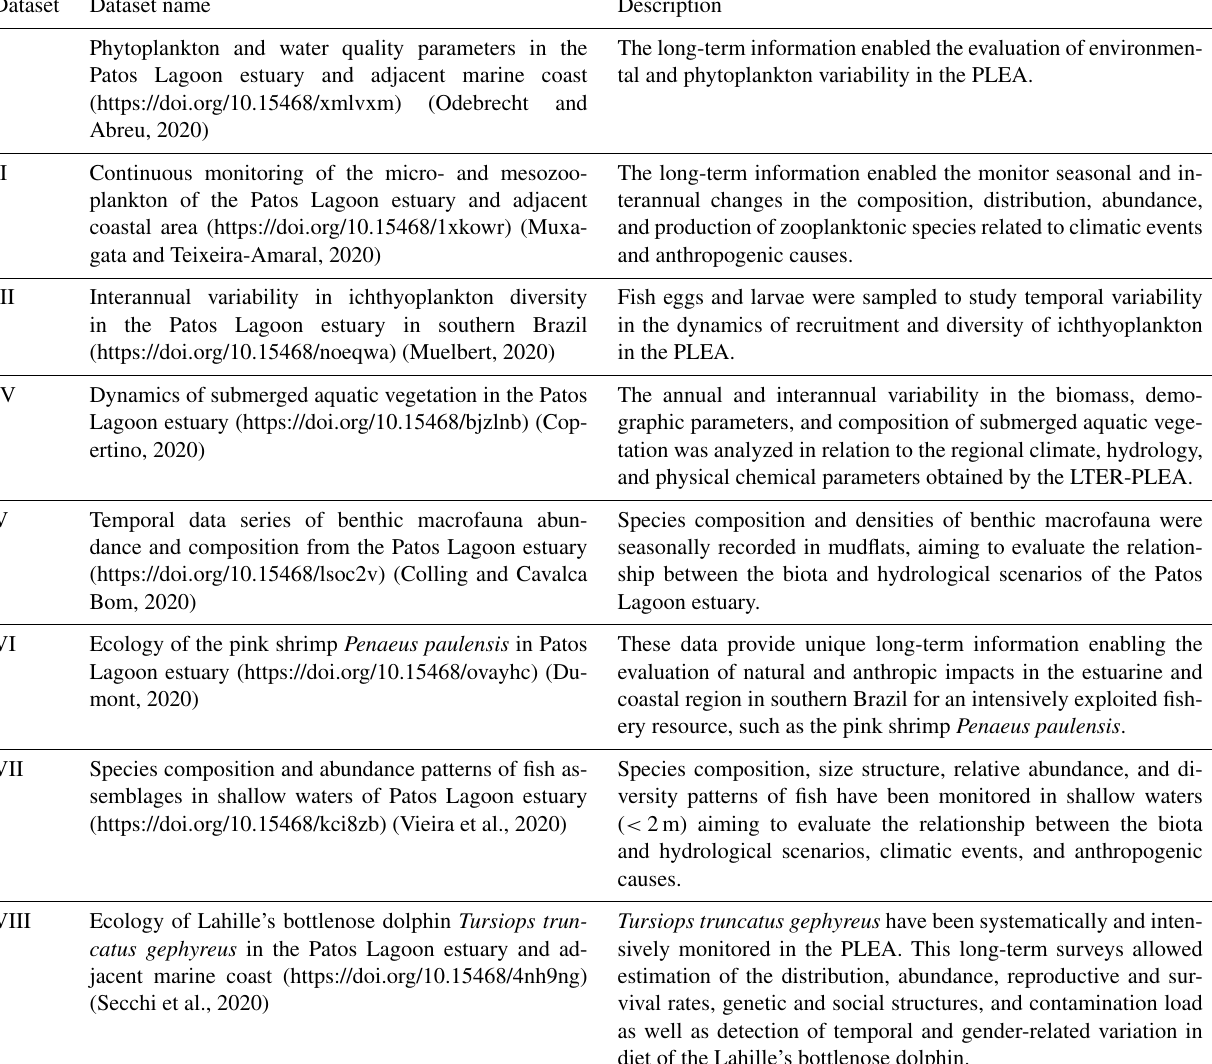
Table 3. Description of the LTER-PLEA’s datasets.